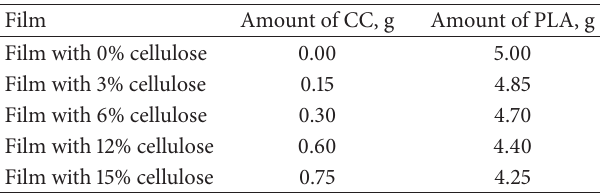
Table 1: Composition of PLA/cellulose